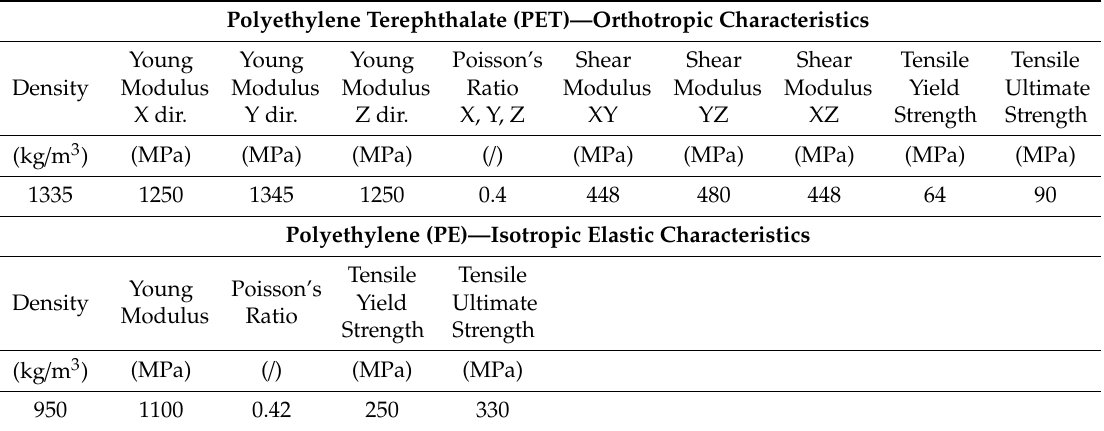
Table 1. Material characteristics of PET and